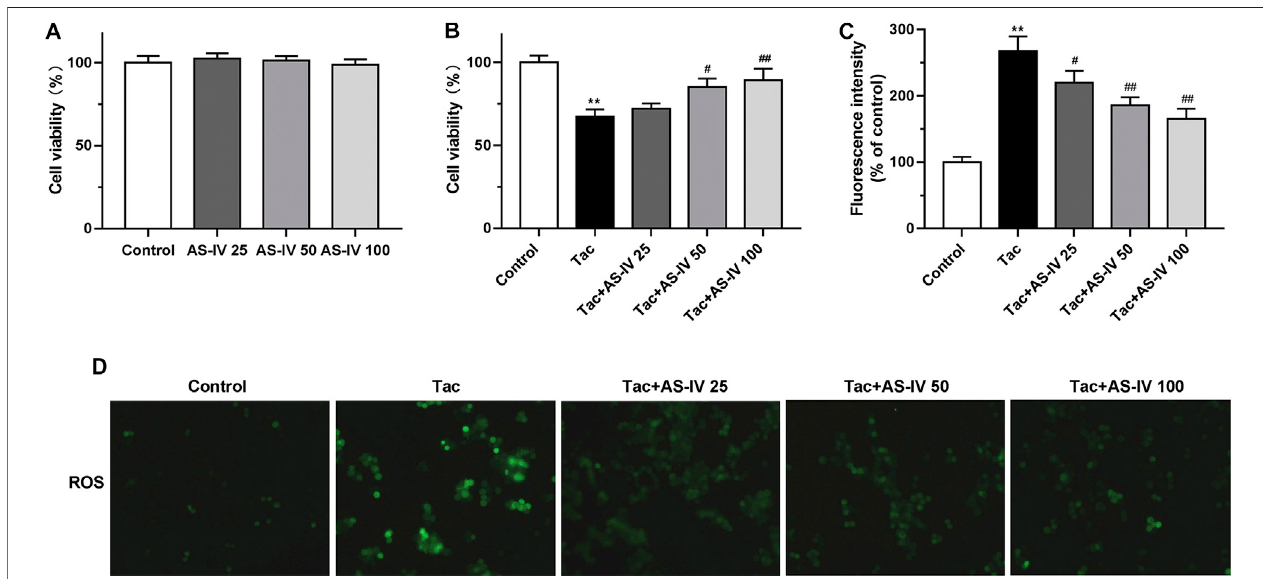
FIGURE3| Thecell protectiveand ROSscavenge effect ofAstragalosideIVin HK-2cells (A – B) HK-2 cellswere treatedwith Astragaloside IV (25, 50or100 μ M) ± tacrolimus (15 μ M) for 24h, and then the cell viability was measured using Cell Counting Kit-8 assay. The results were calculated from three independent experiments (C – D) The levels of intracellular ROS were detected with 2 ′ , 7 ′ -dichlorodihydro fl uorescein diacetate (H2DCFDA) assay. Results were calculated by the intensity of eight fi elds from three independent experiments. ** p < 0.01 vs. the Control group; # p < 0.05 and ## p < 0.01 vs. the Tac group.